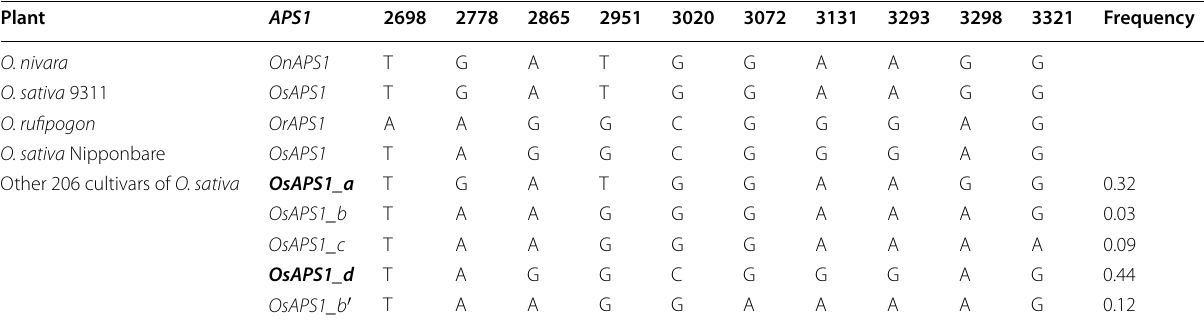
Table 3 Comparisons of model genomes (upper panel) with alleles of OsAPS1 (lower panel) identified in a survey of rice cultivars